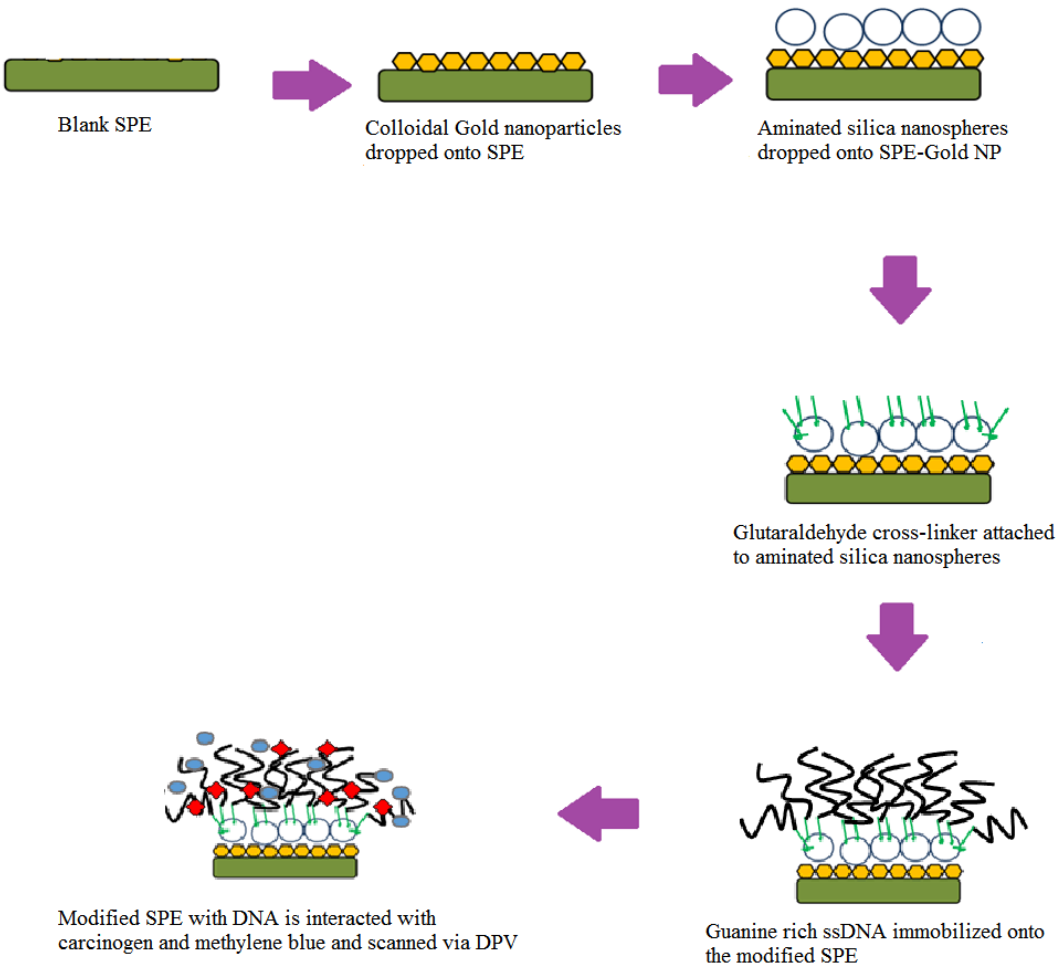
Figure 1. The fabrication process of the DNA biosensor starting from blank screen-printed electrode (SPE) to the immobilization of DNA onto the modified (SPE-Gold nanoparticles) before being exposed with carcinogen and methylene blue (MB). Differential pulse voltammetry (DPV).